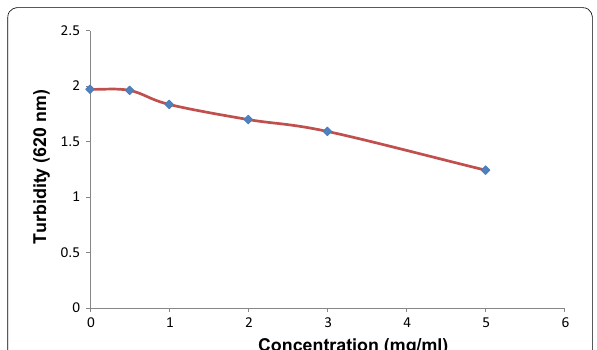
Fig. 1 Effect of aqueous methanolic extract of Triclisia gilletii on turbidity in nucleation assay